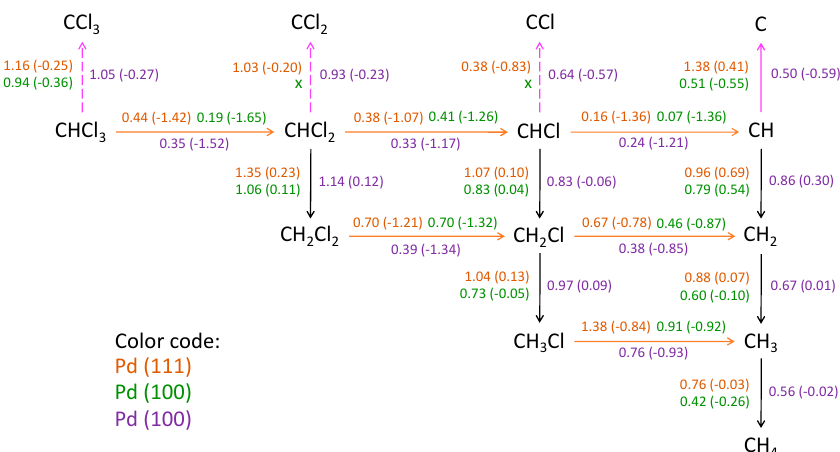
Figure 8. Activation energy barriers (in eV, outside the parentheses) and reaction energies (in eV, inside the parentheses) of surface elementary reaction steps. Orange arrows: dechlorination; black arrows: hydrogenation; pink arrows: dehydrogenation. Dashed arrows: dehydrogenation steps energetically unfavorable. “X”: it was unable to determine any feasible reaction path. Reprinted with permission from ref. [26].